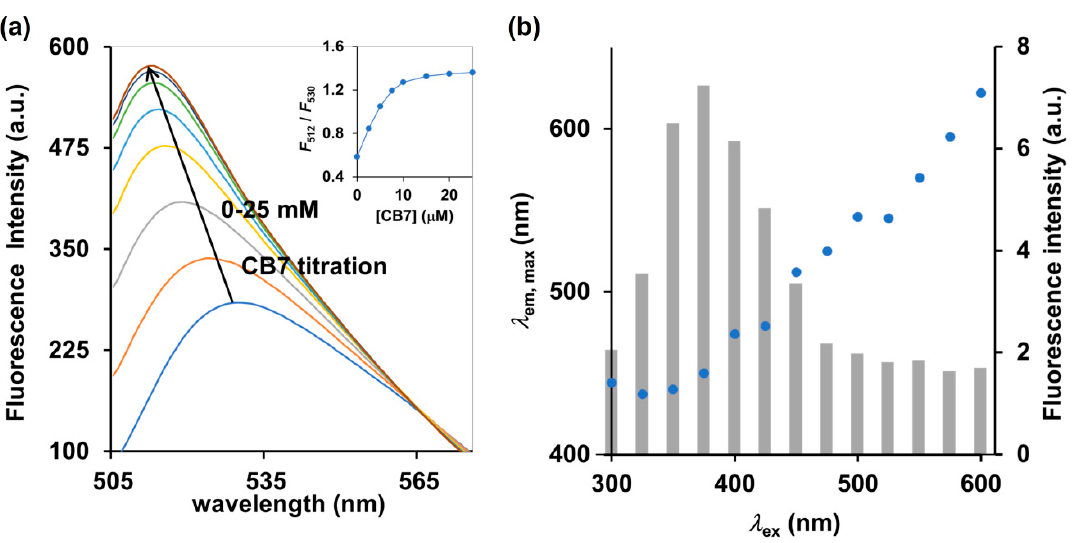
Figure 2. ( a ) Fluorescence spectrum and (inset) ratiometric change ( F 512 / F 530 ) of AOH + (5 μ M) upon addition of CB7 (0–25 μ M) in 10 mM ammonium acetate buffer (pH 4.0), λ ex = 498 nm. ( b ) Autofluorescence of Cordyceps militaris extracts at different excitation wavelengths ( λ ex ). The left and right y-axes represent the maximum emission wavelength ( λ em,max , blue circle) and the corresponding fluorescence intensity (gray bar), respectively.